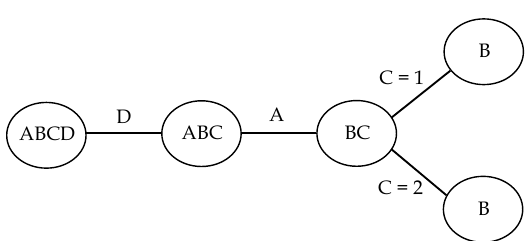
Figure A27. Tree graph for the analysis of the effect of factor B on the convergence performance.